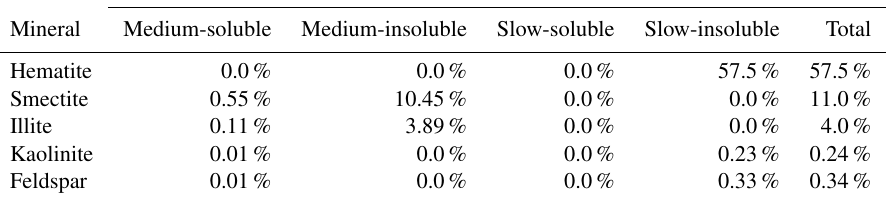
Table 3. Mass fraction of iron in each simulated iron-bearing dust mineral species and allocation to each mineral iron tracer at emission. At emission medium-soluble iron is equivalent to the fast-soluble iron fraction (i.e. the fraction which is already assumed to be soluble at emission). Residual mineral dust mass is then advected as its respective tracer.